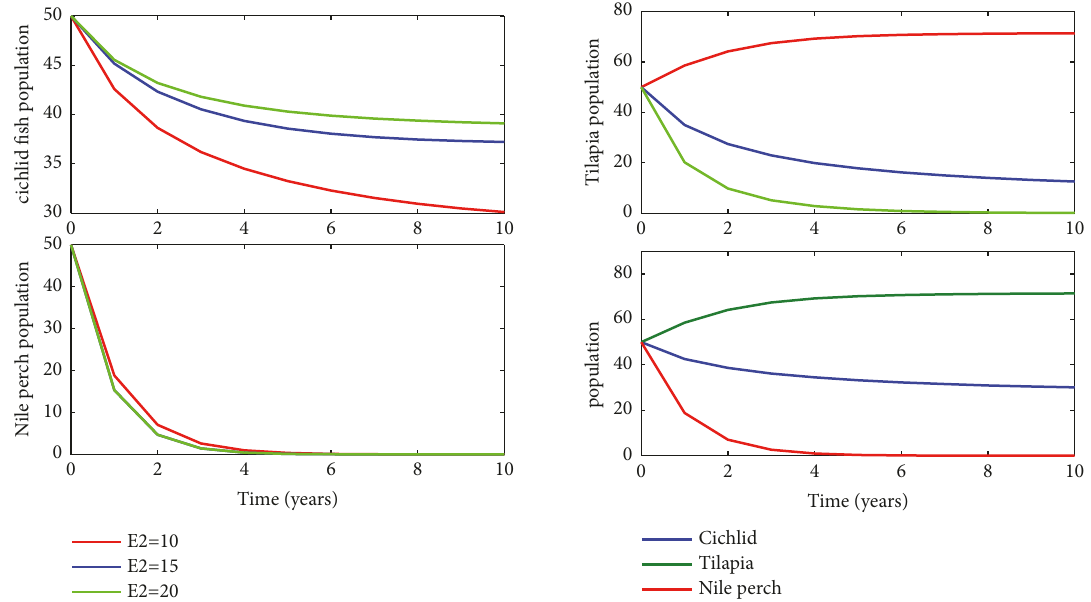
Figure 4: The effect of Tilapia harvest with different values of 𝐸2 with fixed values of 𝐸1 and 𝐸3